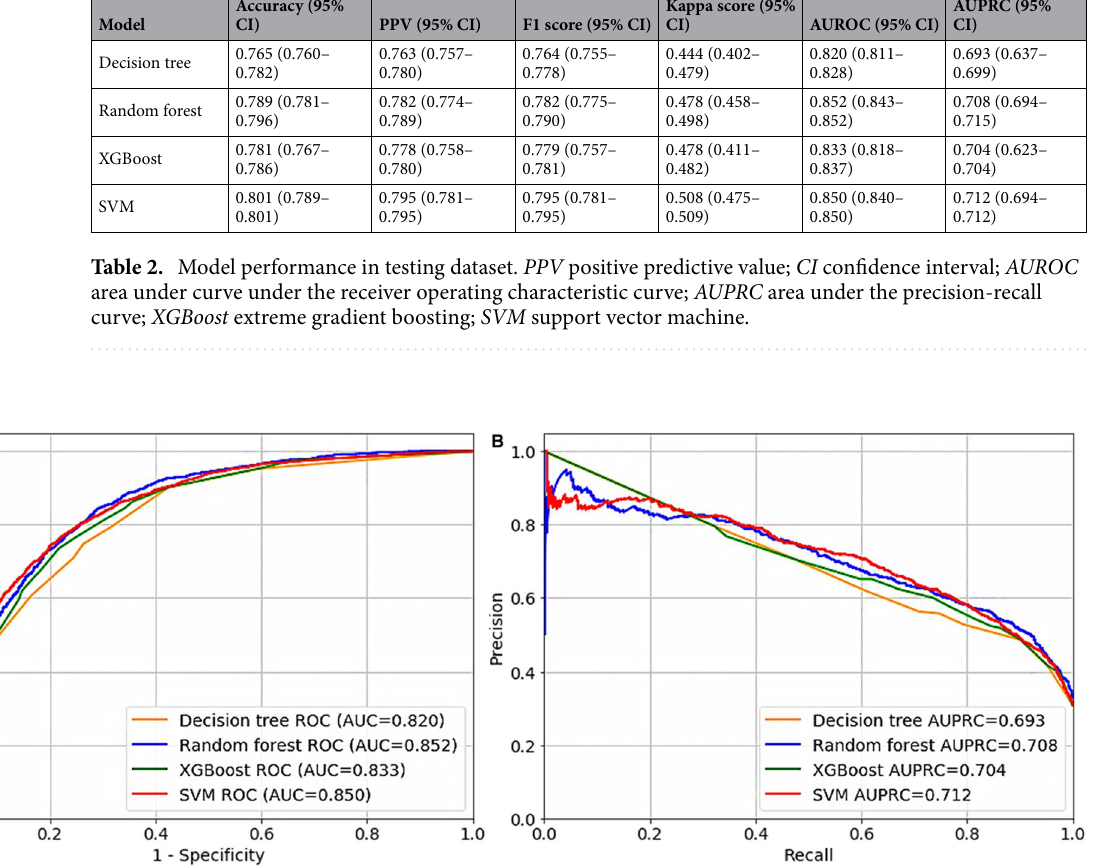
Figure 1. Receiver operator characteristic curves and precision-recall curve. ( A ) Receiver operating characteristic curve. ( B ) Precision-recall curve. XGBoost extreme gradient boosting. SVM support vector machine. ROC operating characteristic curve. AUC area under curve. AUPRC area under the precision-recall curve.